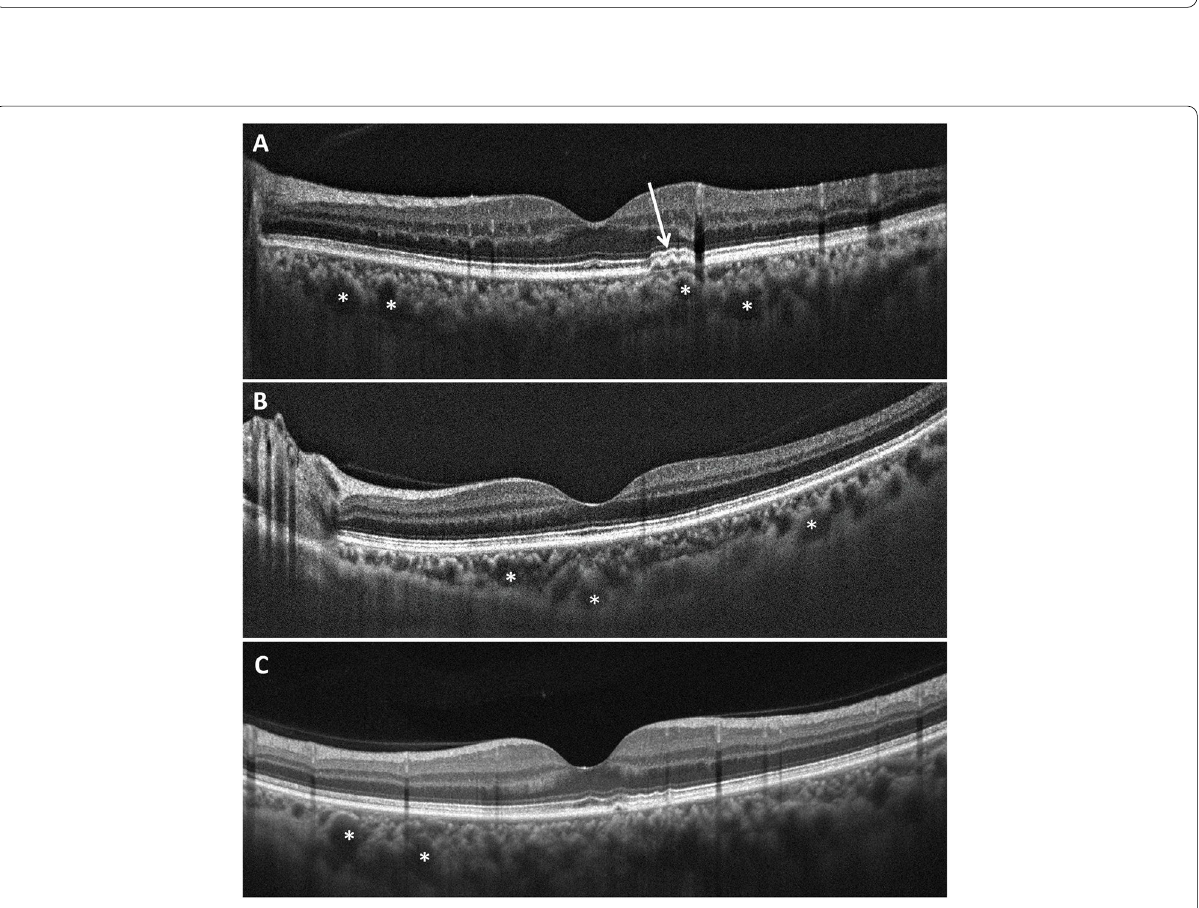
Fig. 3 Spectral domain optical coherence tomography finding of macular area in a representative patient with coronavirus disease 2019. Note the dilated choroidal vessels (asterisks), and overlying retinal pigment epitheliopathy (white arrows). The findings are similar to those in pachychoroid